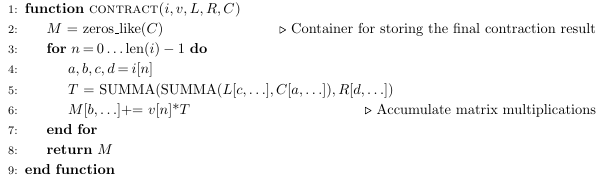
Algorithm 1. Contraction